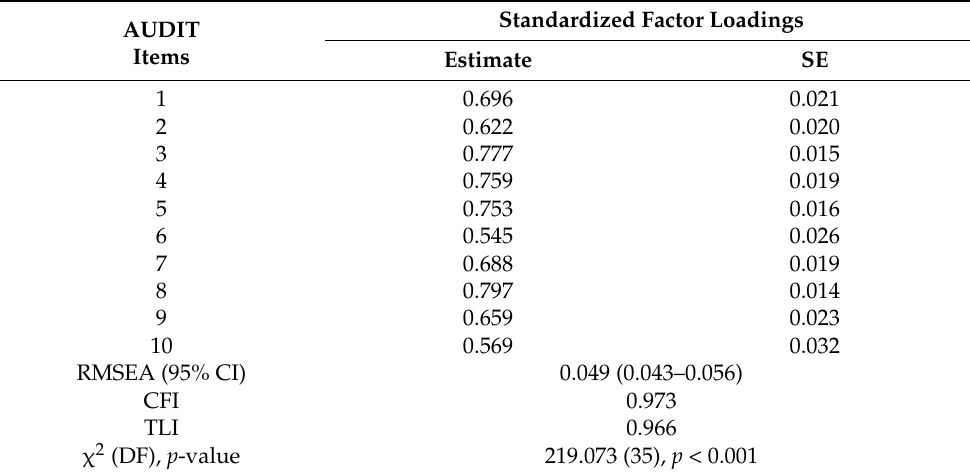
Table 3. Standardized factor loadings from a confirmatory factor analysis with one factor of the online version of the AUDIT administered in the UNIVERSAL sample ( n =